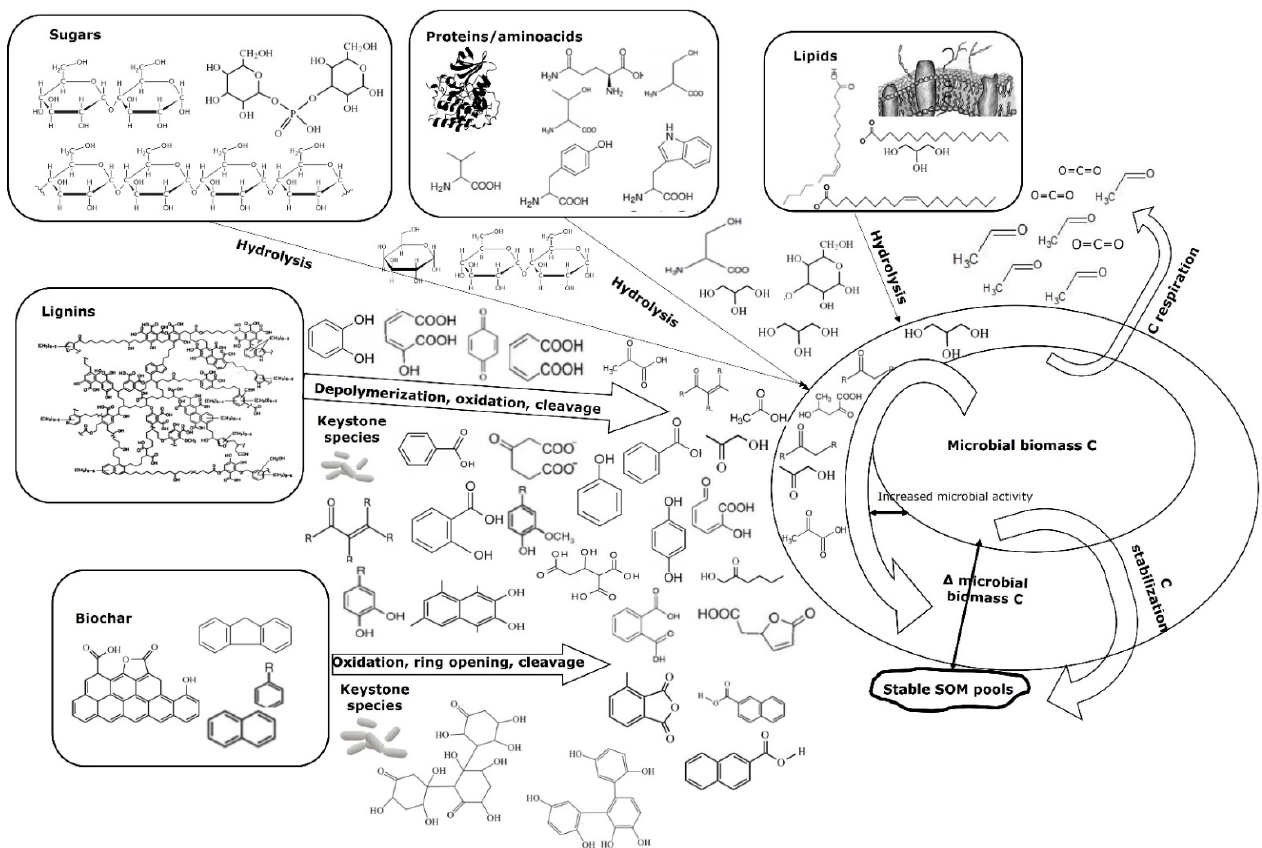
Figure 3. The chemical modification of biochar and organic substances in biochar amended soils and the potential metabolic